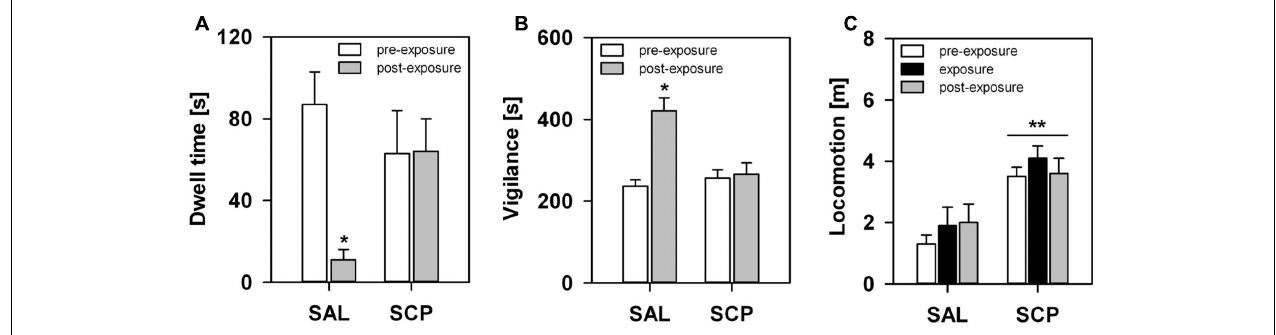
FIGURE 4 | Marmosets’ behavioral response in the FMB procedure. An acute saline (SAL; n = 4) or SCP (0.03 mg/kg SCP; n = 5) administration was given subcutaneous immediately before the pre-exposure trial. All trials lasted 10 min and were held at 10 min intervals. Time spent in seconds (A) in the snake-paired quadrant of the open-field apparatus and (B) vigilant of the surroundings, before (pre-exposure trial) and after (post-exposure trial) being exposed to the snake model. (C) Total distance traveled in meters during each of the three trials of the procedure. All data are represented as mean + SEM. ∗ p < 0.05 vs. the pre-exposure trial of the SAL group, ∗∗ p < 0.05 SCP vs. SAL